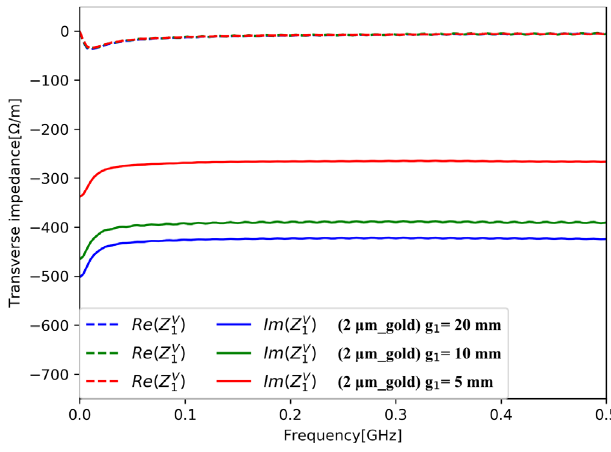
FIG. 12. Real and imaginary part of vertical broadband impedance for the ceramic rings coated by 2 μ m-gold with different gaps.